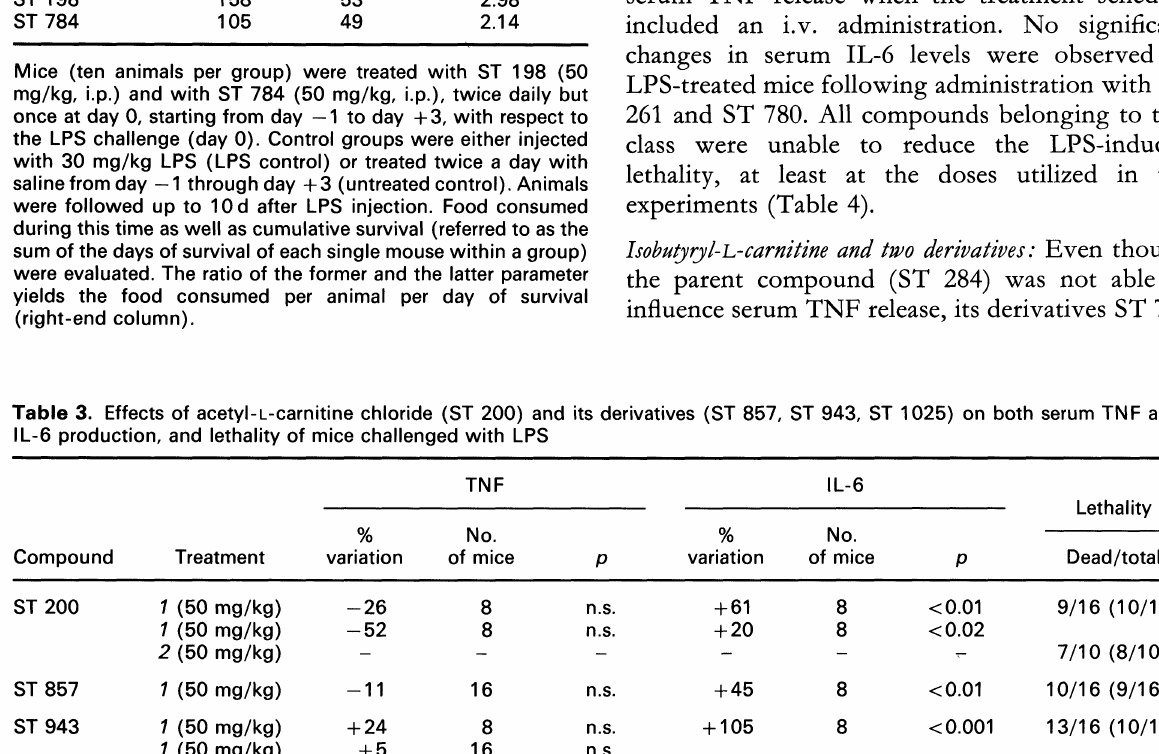
Table 2. Health conditions, evaluated by food intake of LPS-challenged mice following treatment with ST 198 and ST 784 Food Cumulative Food consumed per consumed survival animal per day Compound (g) (d) of survival Untreated control 311 100